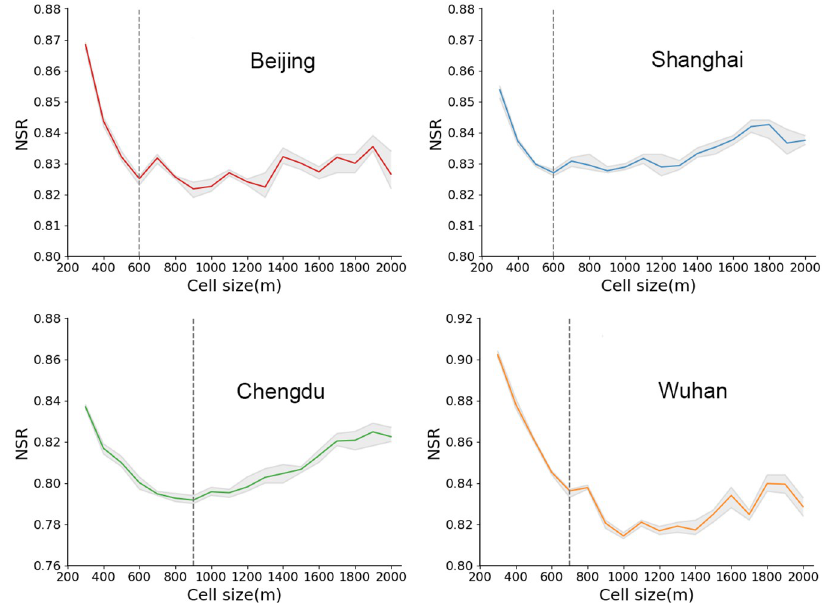
Fig 6. The correlation between the NSR and the cell size in Beijing, Shanghai, Chengdu, and Wuhan. The gray shades represent the range of multiple runs. The solid lines mark the average value of all experiments.